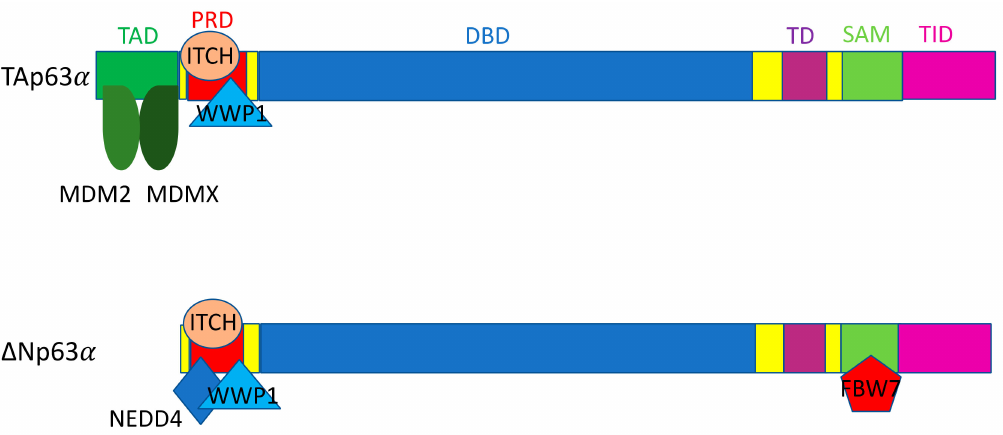
Figure 2. Schematic representation of interaction of p63 with di ff erent E3 ligases. Legend: SAM, sterile alpha domain; TID, trans inhibitory